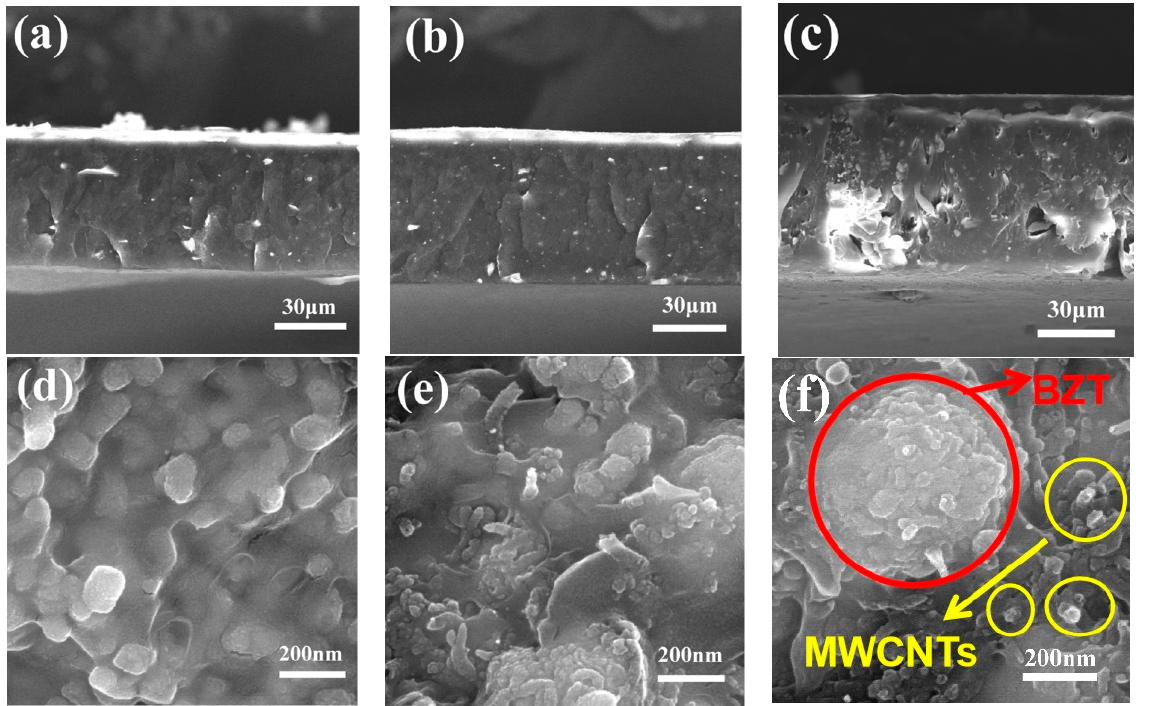
Figure 6. Cross-section morphology of composite films with ( a ) 0.25 vol%; ( b ) 0.50 vol%; and ( c ) 1.00 vol% MWCNTs. The scale bar is 30 μ m. ( d–f ) are the high-resolution images of ( a–c ), respectively. The scale bar is 200 nm.